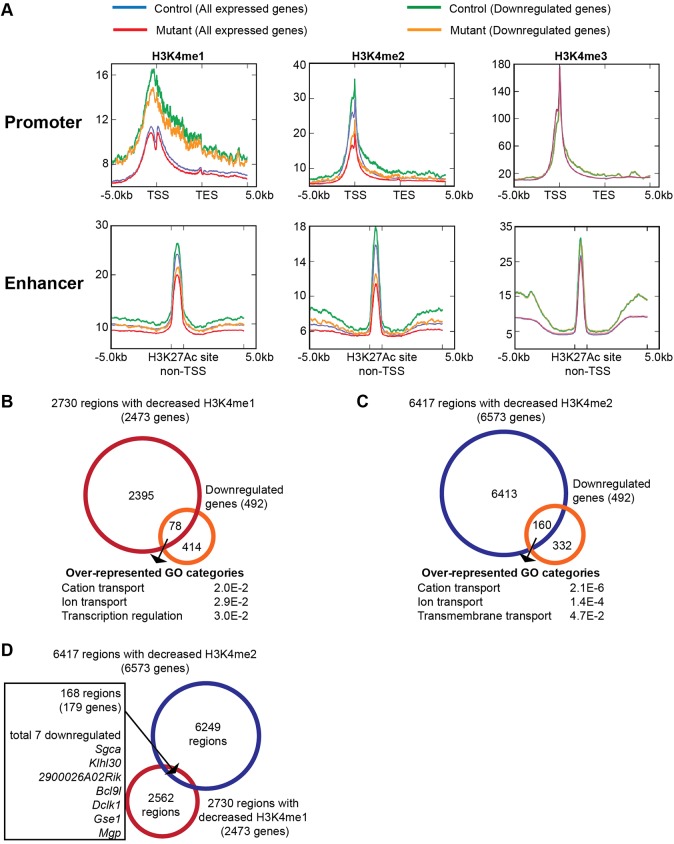
Myocardial deletion of Kmt2d results in a decrease in average H3K4me1 and H3K4me2 levels at enhancers and promoters. (A) Metagene profiles showing the average distribution of H3K4me1, H3K4me2 and H3K4me3 input-normalized tag density at promoters and enhancers in E11.5 control and Tnnt2::Cre;Kmt2d fl/fl hearts. For all expressed genes and 492 downregulated genes analyzed, mutants show decreased H3K4me1 levels at enhancers, decreased H3K4me2 levels at promoters and enhancers, and no difference in H3K4me3 levels. (B) 2730 regions with decreased H3K4me1 levels (FDR<0.1) are assigned to 2473 genes by proximity using Stanford GREAT. GO categories of 78 downregulated genes with decreased H3K4me1 in mutant hearts are over-represented for ion transport genes. (C) 6417 regions with decreased H3K4me2 levels (FDR<0.1) are assigned to 6573 genes by proximity using GREAT. GO categories of 162 downregulated genes with decreased H3K4me2 are over-represented for ion transport genes. (D) Venn diagram representing the overlap of 2730 regions with decreased H3K4me1 with 6417 regions with decreased H3K4me2. Of the overlapping 168 regions mapped to 179 genes, only seven genes are downregulated in E11.5 Tnnt2::Cre;Kmt2d fl/fl hearts. TSS, transcription start site; TES, transcription end site.